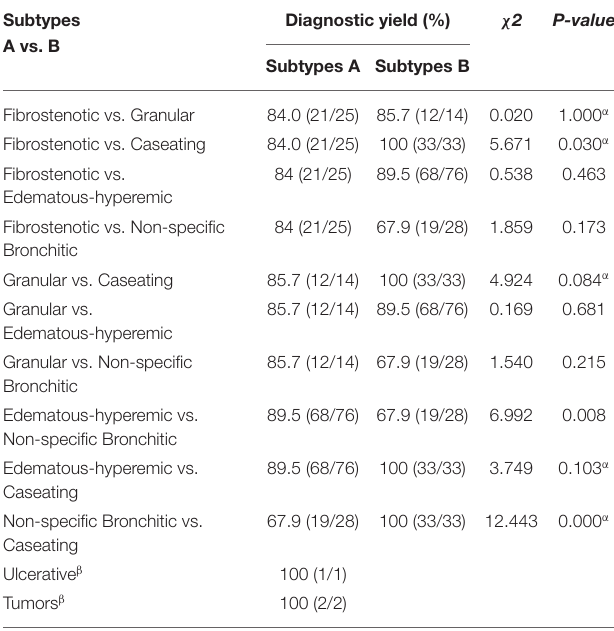
TABLE 4 | Diagnostic yield of the Xpert MTB/RIF in BALF according to bronchoscopic TBTB